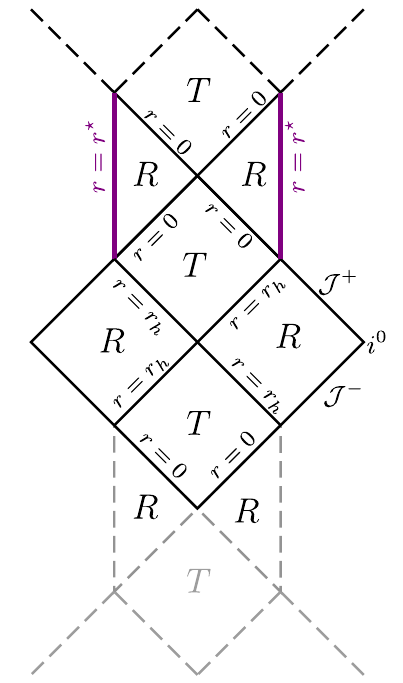
Fig. 2 Carter–Penrose diagram for case q = 1 , 3 , 5